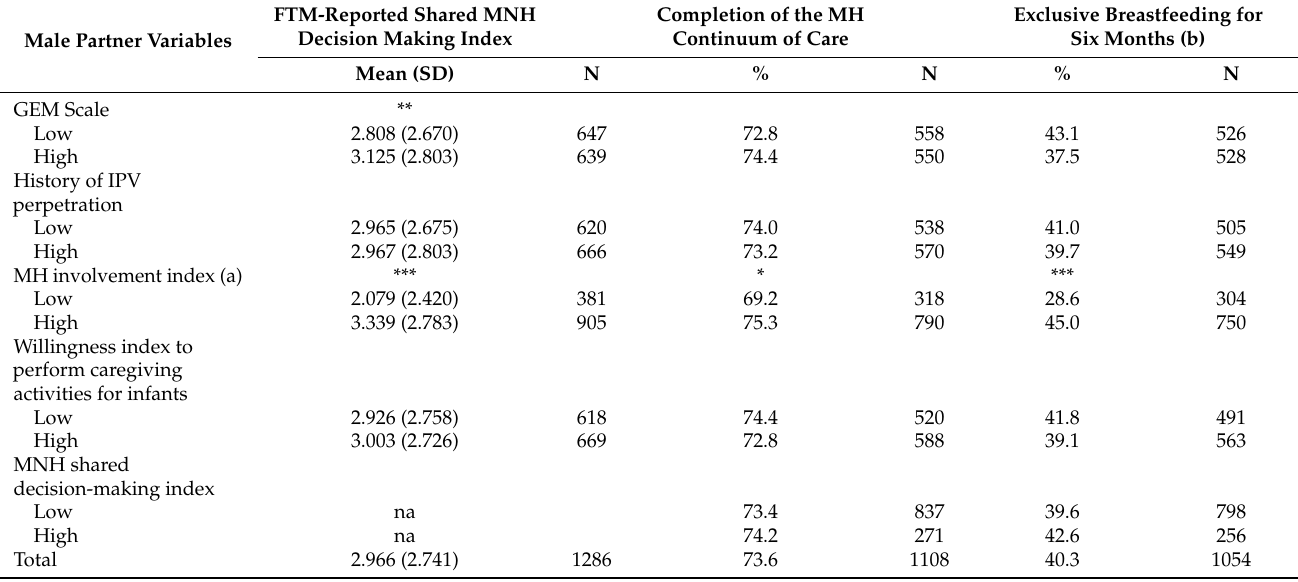
Table 3. Mean shared decision-making index and percentage of FTMs with specific maternal and child health outcomes by indicators of the male partner’s gender-equitable attitudes and behaviors, Kinshasa,